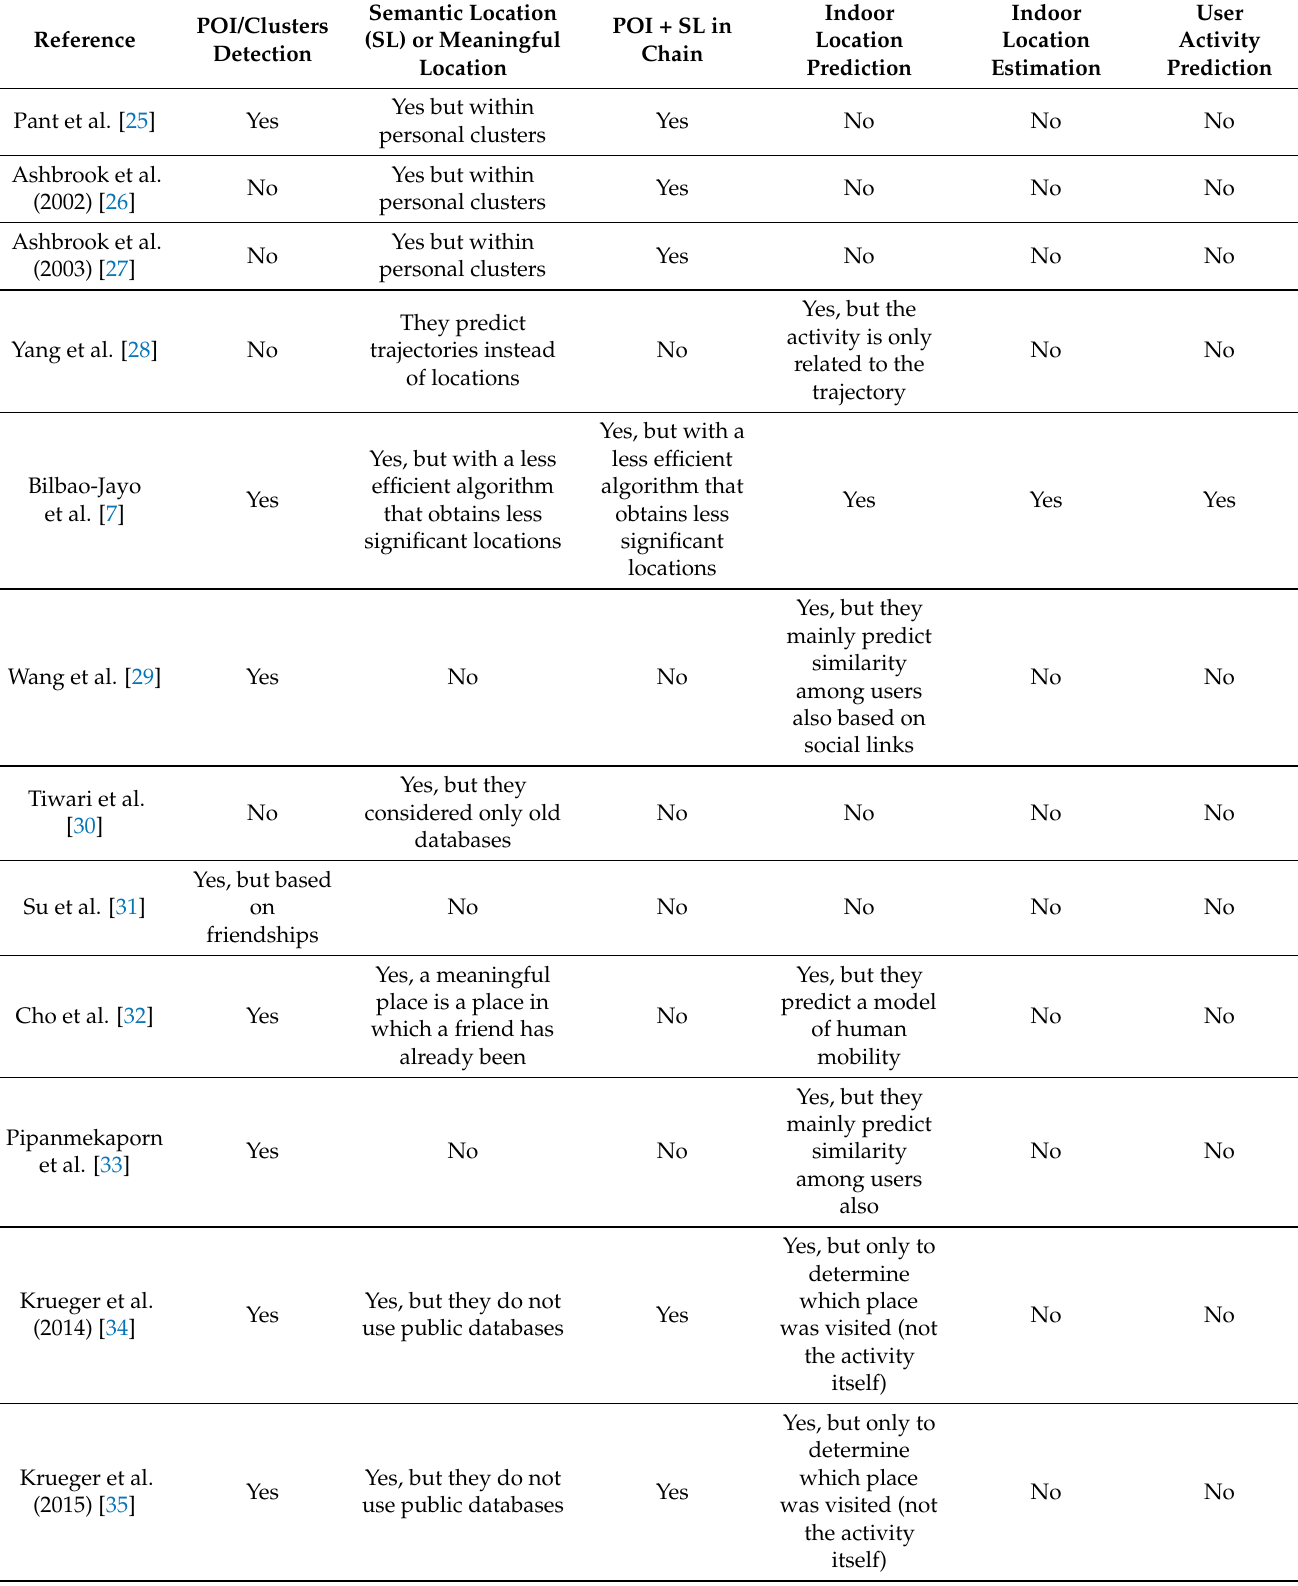
Table 1. Overview on methods and technologies used in related